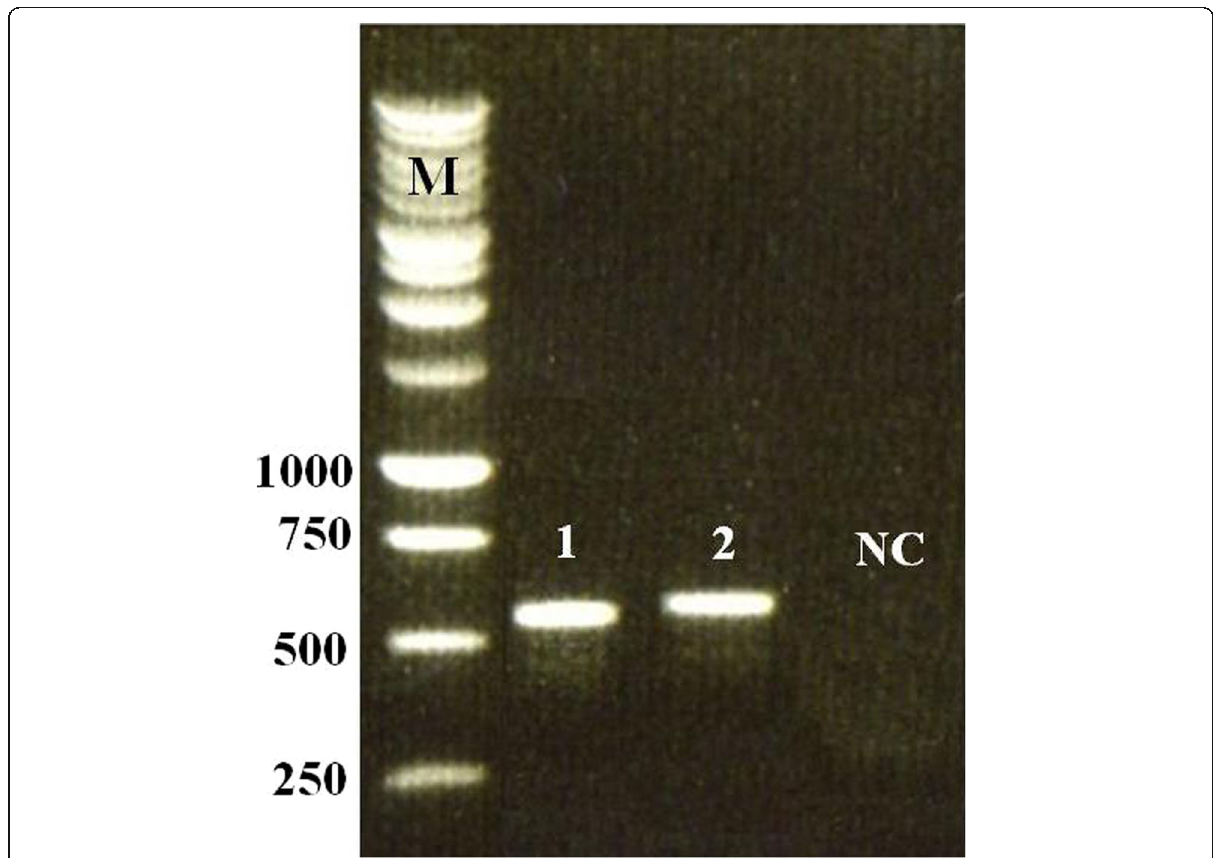
Fig. 2 DNA products amplified by polymerase chain reaction (PCR) from F. solani ( 1 ) and R. solani ( 2 ) isolated from diseased cucumber roots. NC negative control (no template DNA added). M, 1 Kbp DNA ladder marker (Promega, Madison,